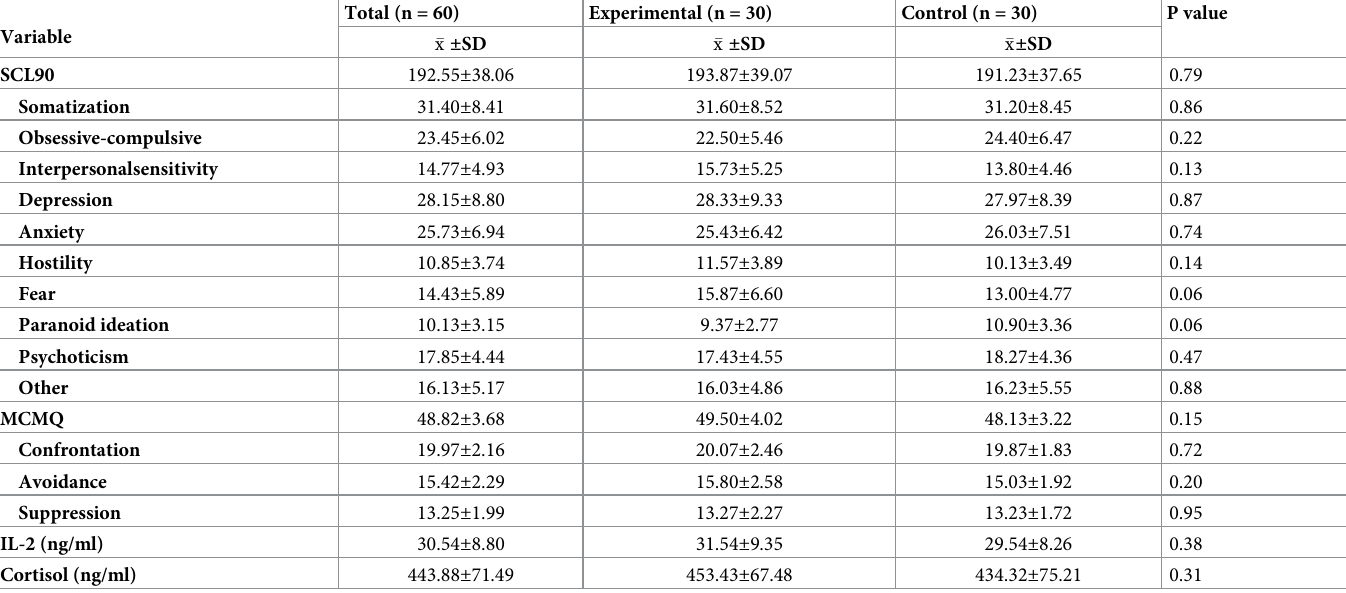
Table 3. Comparison of SCL-90, MCMQ, IL-2 and cortisol between groups before the intervention.